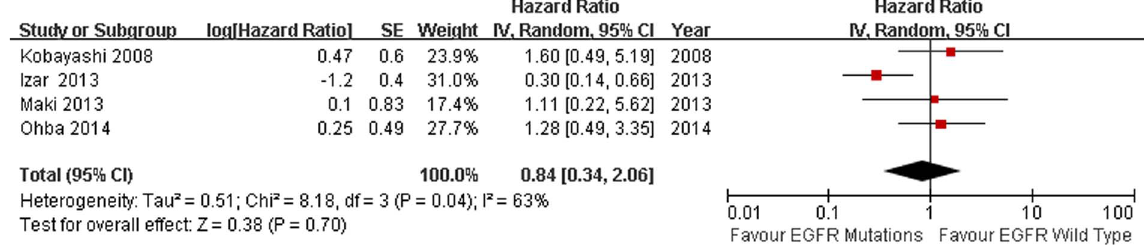
Figure 8. Random-effect model forest plot of HR of OS in pathologic stage subgroup analysis according to EGFR mutation status. Solid diamond indicates the pooled HR of OS, Square indicates hazard ratio value of each study.